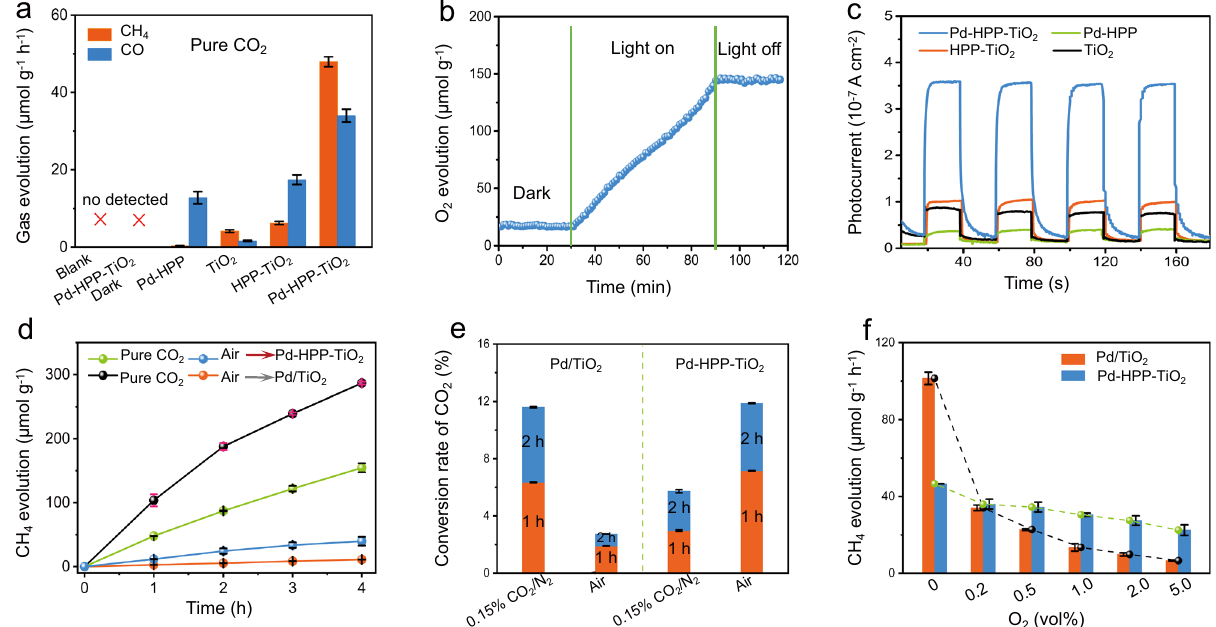
Fig. 2 Evaluation of photocatalytic CO 2 reduction. a The evolution rates of CH 4 and CO in pure CO 2 . b On-line monitoring of O 2 evolution during the photocatalytic reaction over Pd-HPP-TiO 2 . c Photocurrent response during light on-off cycling. d Comparison of the CH 4 evolution rates in pure CO 2 and air. e The conversion yield of CO 2 by measuring the CO 2 concentration. f Effect of O 2 concentration (vol%) in CO 2 /O 2 gas mixture on the CH 4 evolution rate. The results in ( a , d , e , f ) are the average values of three parallel experiments. The error bar represents the standard deviation of the